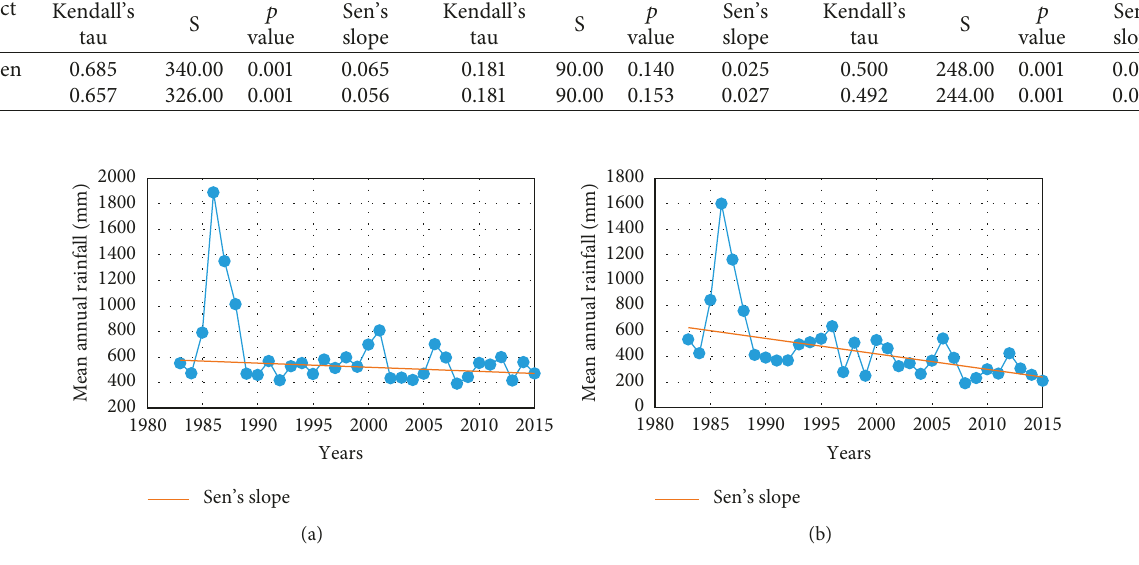
Table 6: Annual and seasonal temperature trend analysis by the MKT test for Hawzen and Irob in 1983–2014. District